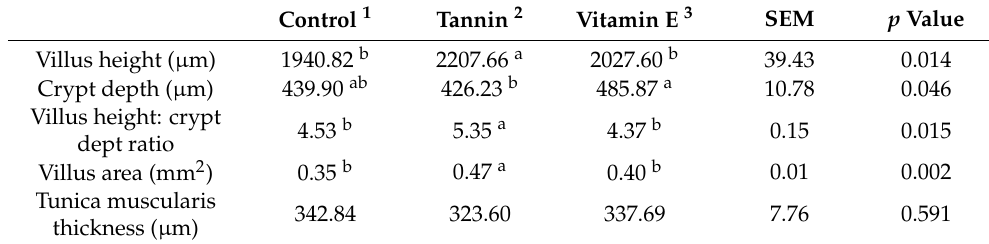
Table 6. Effect of chestnut tannins and vitamin E on the intestinal morphology of broiler